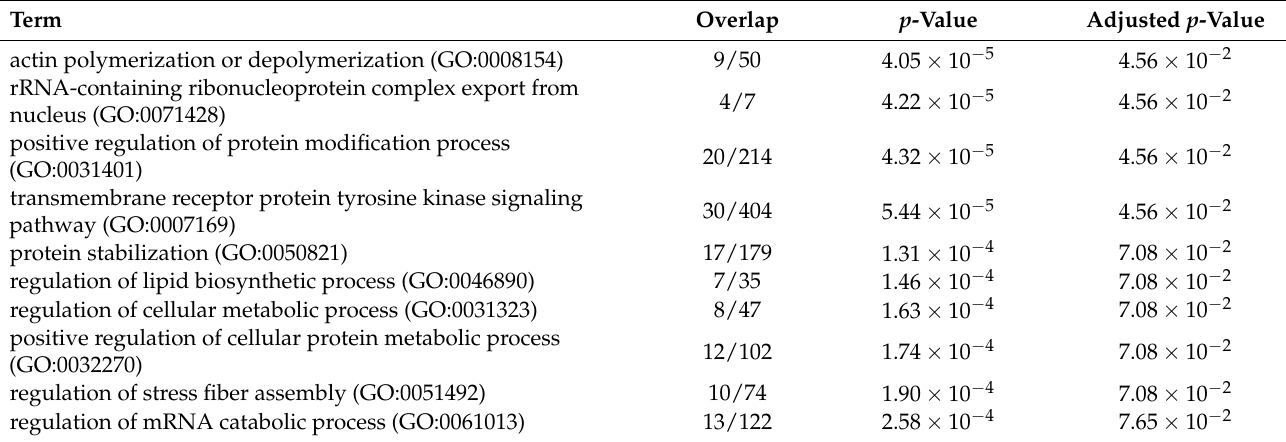
Table 7. The top 10 enriched terms in “GO Biological Process 2021” using Enrichr. Overlap is the number of common genes between the genes uploaded and the genes in the category divided by the number of genes in the category. Probes, whose associated genes were uploaded to Enrichr, were identified using linear